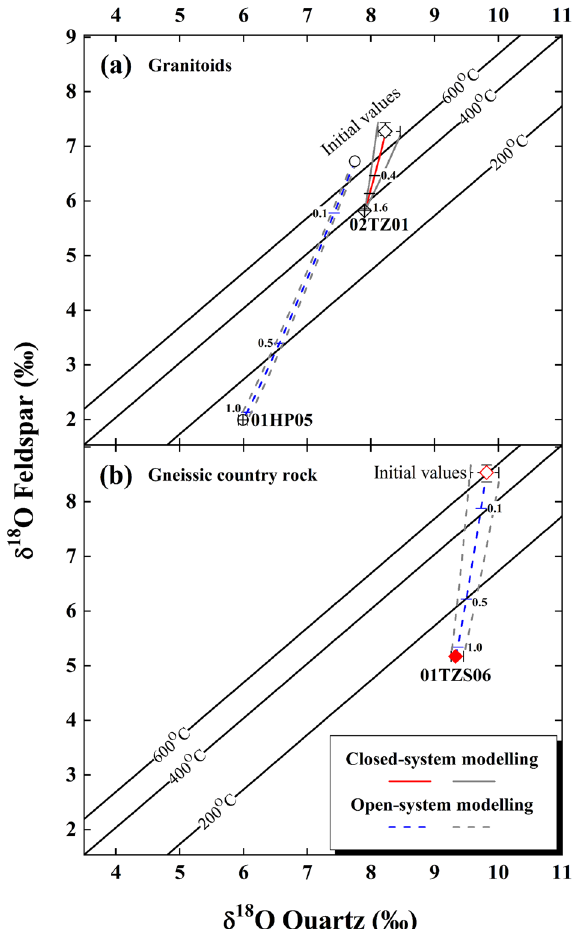
Figure 3. Diagrams of quartz vs. alkali feldspar δ 18 O values for the granitoids ( a ) and gneissic country rock ( b ) from the Dabie orogen. The curves with gray envelopes denote the maximum variability for the concurrently lowered oxygen isotopes of rock-forming minerals, re-equilibrated with the externally infiltrated meteoric water (blue) or internally buffered yet evolved magmatic water (red), respectively, throughout this study. Small ticks with numbers are W/R ratios. Other details refer to Figs. S1–S3 and Fig.